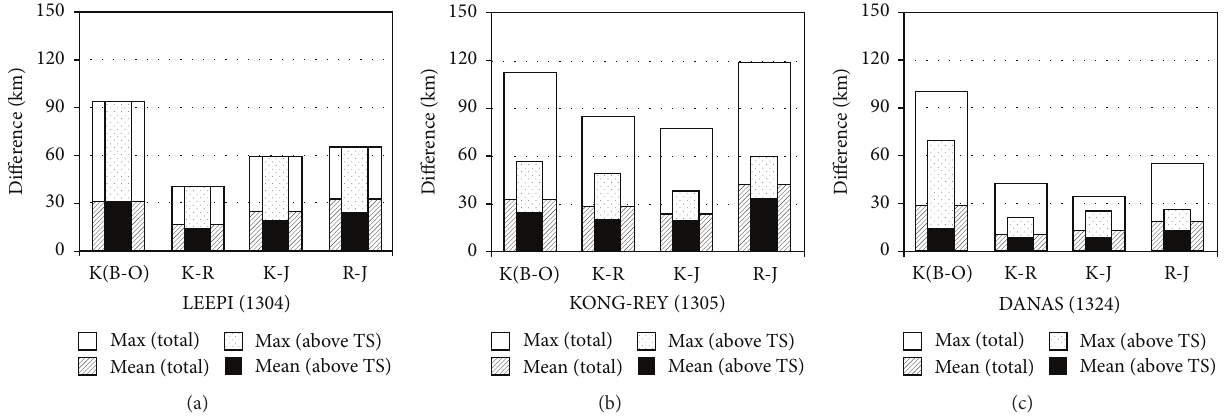
Figure 11: Differences (km) in the position of the TC center between KMA best tracks (B) and real-time operations (O) and among best tracks from KMA (K), RSMC (R), and JTWC (J) for Typhoon LEEPI (1304), KONG-REY (1315), and DANAS (1324). Here “above TS” denotes the differences in the TCs categorized as a tropical storm or